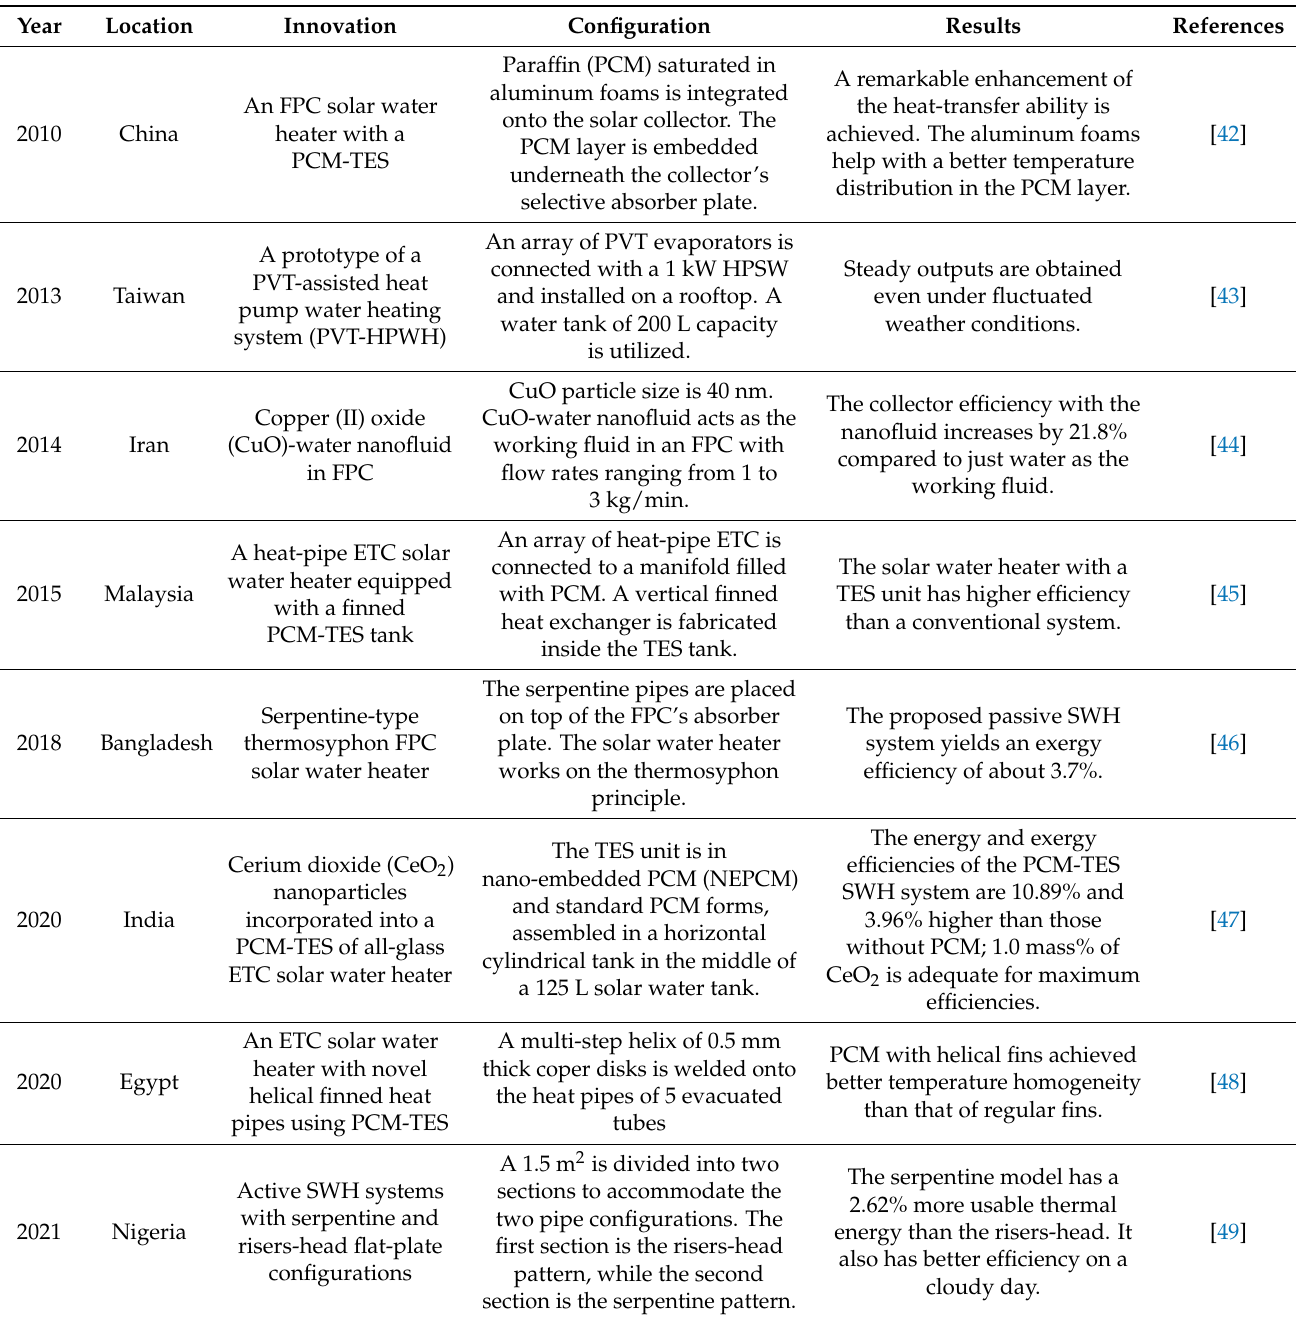
Table 3. Several global innovations of SWH technologies in the recent